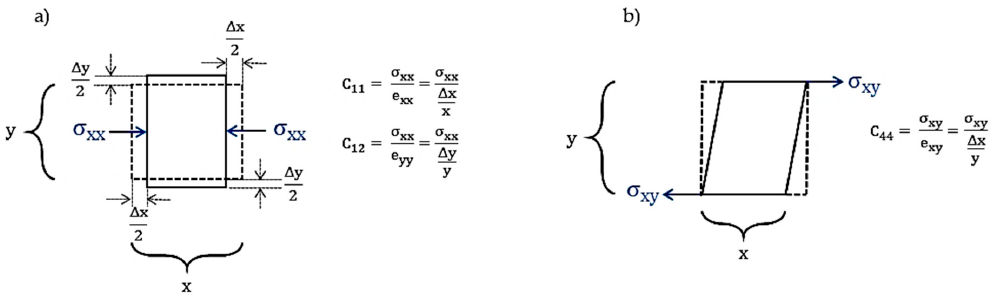
Figure 5. ( a ) Longitudinal compression C 11 and transverse expansion C 12 ; ( b ) shear modulus C 44 [39].